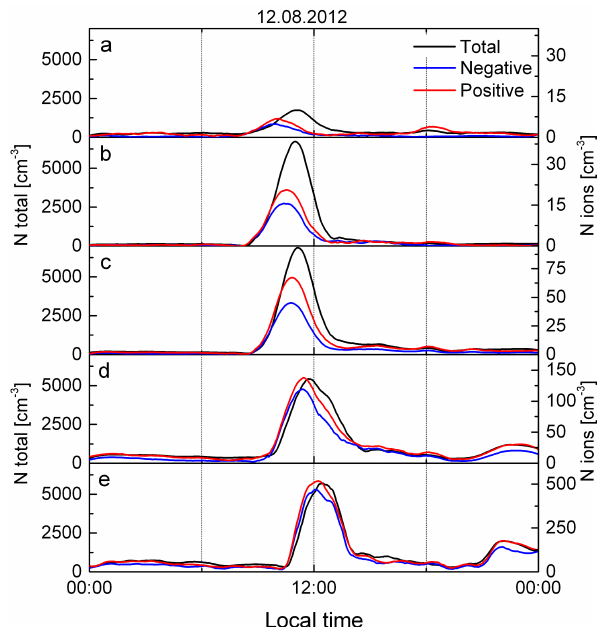
Figure 4. Temporal evolution of total particle concentrations as well as positive and negative ion concentrations in diameter ranges of (a) 1.8–2.1nm, (b) 3.7–4.3nm, (c) 7.6–8.8nm, (d) 13.6–15.7nm and (e) 21.1–24.5nm. The data originates from single NAIS size channels, measured during the NPF event on 12 August 2012 at Waldstein. Ion concentrations increase during the growth process, while total particle concentrations increase rapidly at the beginning of NPF but begin to decrease at diameters above 8 nm. Note that the ion concentrations (right axes) are always smaller than the par- ticle concentrations (left axes). Data was smoothed for illustrational